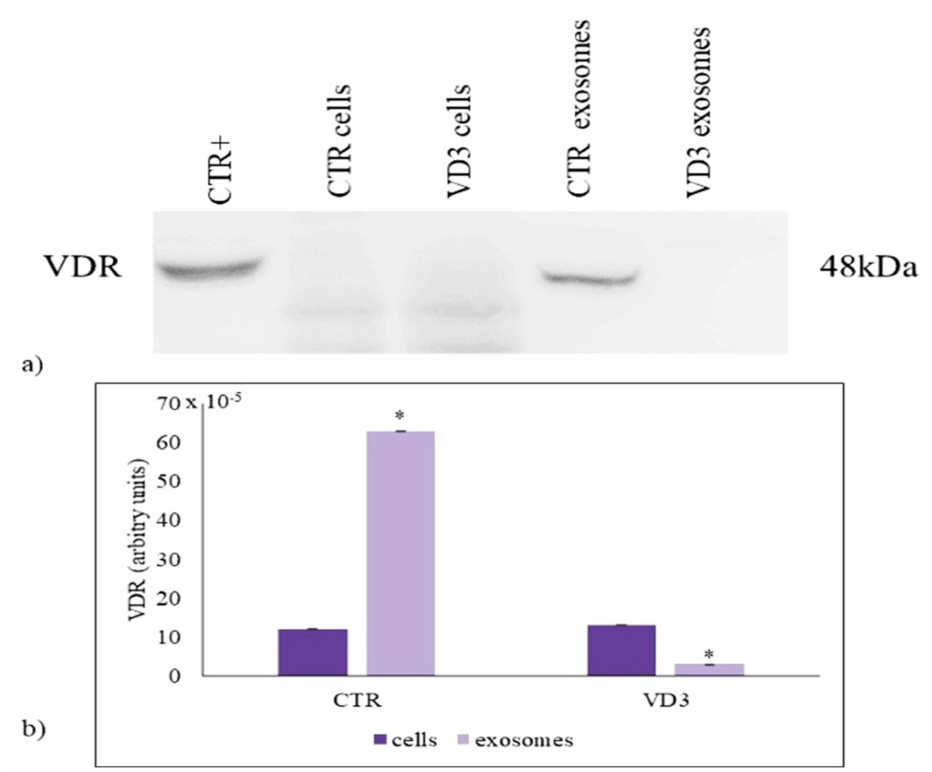
Figure 2. VDR content in cells and exosomes. ( a ) Immunoblotting analysis. The position of the 48 kDa was evaluated in relation to the molecular-weight size markers. NCI-N87 cells were used as positive control [17]; ( b ) The area density was quantified by Chemidoc Imagequant LAS500 by specific IQ programm. Data were expressed as mean ± SD of three independent experiments performed in duplicate (case number: 6). * p < 0.05 versus the control sample. CTR, control sample; VD3, vitamin D3